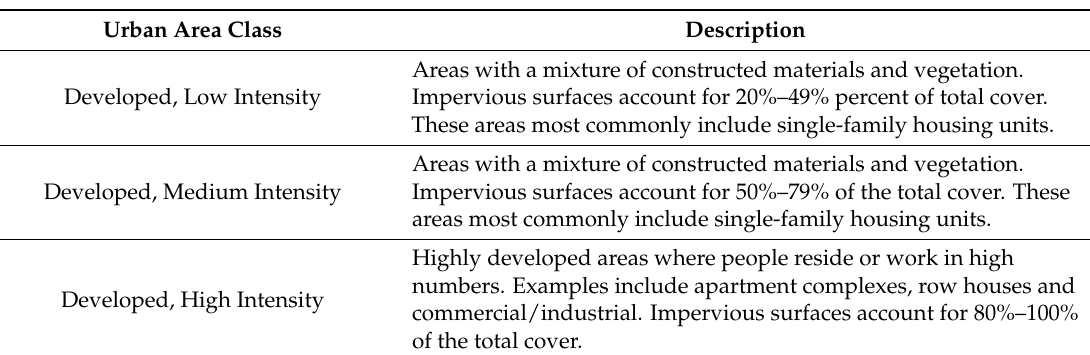
Table 2. Training samples used to determine optimized thresholds extracted from NLCD impervious surface